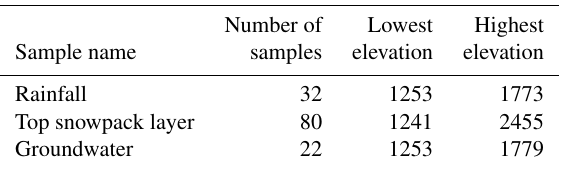
Table 1. Summary of the isotopic data ( δ 2 H and δ 18 O) collected in Vallon de Nant between February 2016 and July 2017. Number of Lowest